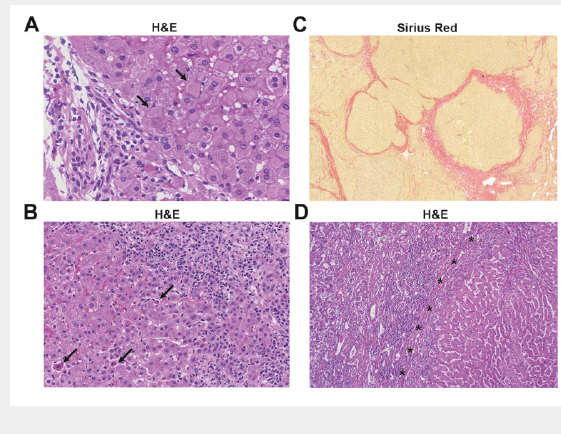
Histology of various human liver diseases. (A) Histology of chronic hepatitis B infection. Chronic inflammation of mild activity mainly confined to the portal tract (left) and numerous hepatocytes with ground class cytoplasm (arrows) due to accumulation of viral proteins (HBsAg) (haematoxylin and eosion staining). (B) Histology of autoimmune hepatitis (AIH). Histology reveals portal and interphase inflammatory activity and numerous plasma cells (right). Note the presence of several apoptotic hepatocytes (arrows) (haematoxylin and eosion staining). (C) Histology of cirrhotic liver tissue. Cirrhosis is characterised by architecturally abnormal nodules of liver tissue, separated by fibrous tissue (red, elastica van Gieson staining) (D) Histology of hepatocellular carcinoma (left) adjacent to cirrhotic liver tissue (right). Note the inflammatory infiltrate at the border between the tumour and surrounding tissue (haematoxylin and eosion